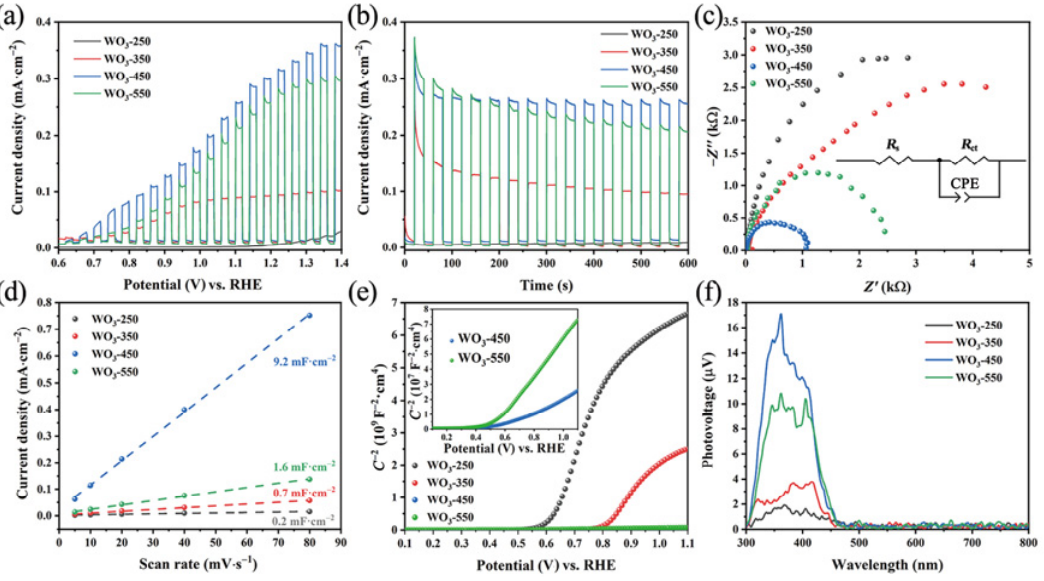
Fig. 6 (a) LSV curves of different WO 3 samples (scan rate = 1 mV·s − 1 ), (b) transient photocurrent responses, (c) EIS Nyquist plots (the inset is the equivalent circuit model for fitting the EIS data), (d) C dl for various catalysts, (e) M–S plots, and (f) SPV spectra for various WO 3